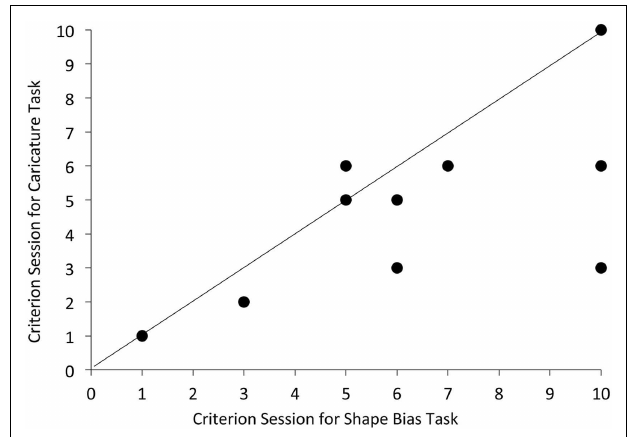
FIGURE 3 | Scatter plot of criterion sessions for success in the Caricature recognition task and Shape Bias task for the 10 children in the 6-month longitudinal sample in Experiment